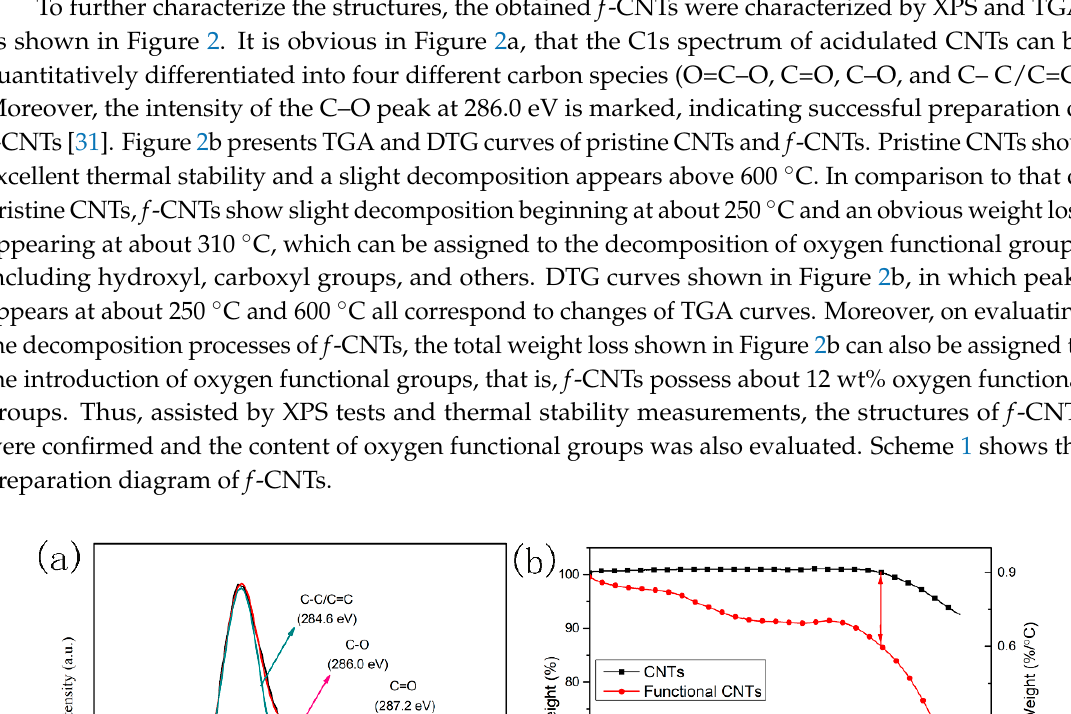
Figure 2. ( a ) XPS spectra and ( b ) TGA curves of f -CNTs.